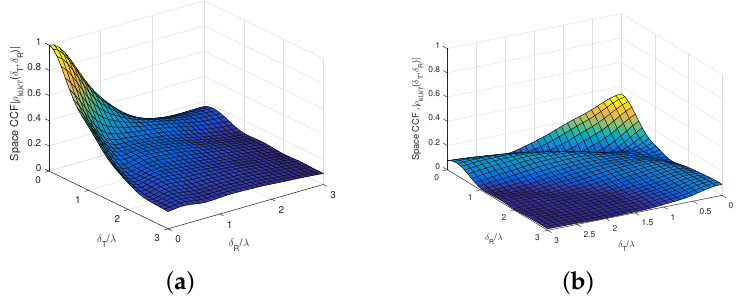
Figure 5. Spatial cross-correlation functions of SET and without ceiling for NLoS scenario ( c R = 0 ) . ( a ) SCCF of SET. ( b ) SCCF of SET without ceiling.